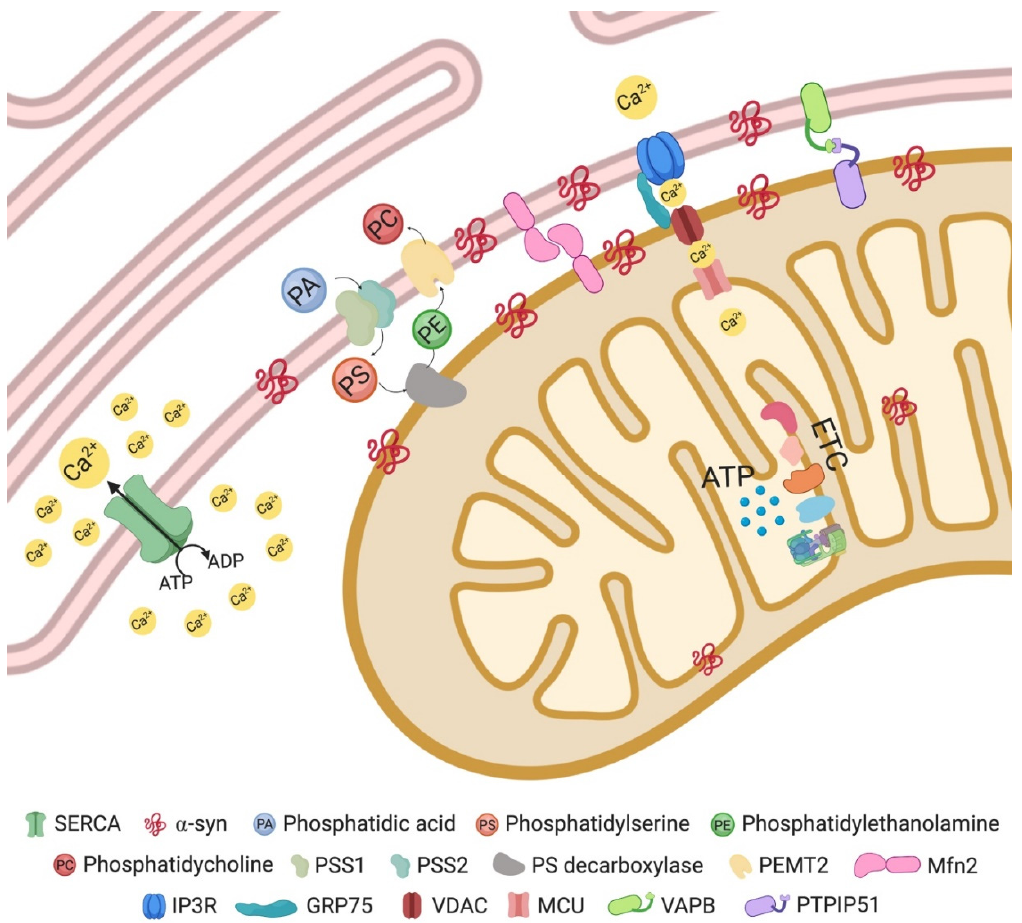
Figure 2. Mitochondria–ER contact site and main resident proteins (see text for details).